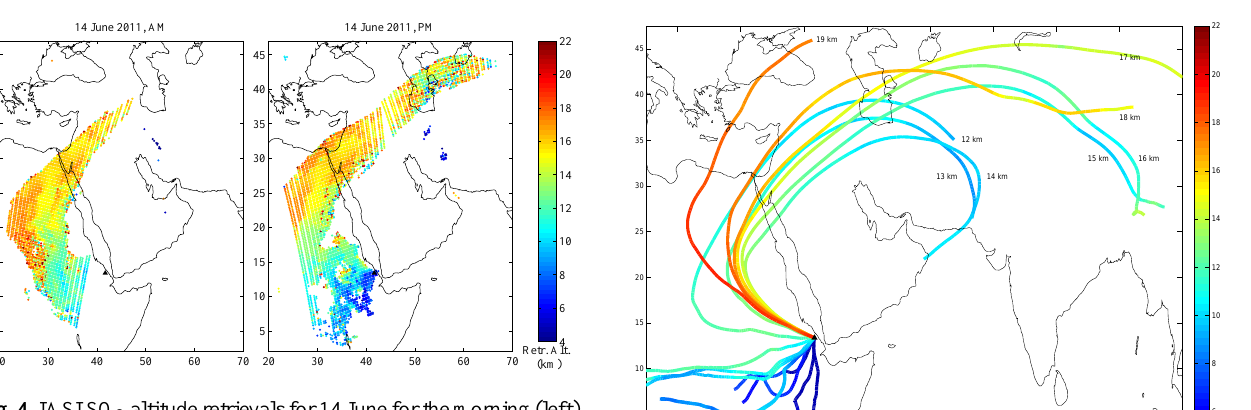
Fig. 4. IASI SO 2 altitude retrievals for 14 June for the morning (left) and evening (right) overpass.